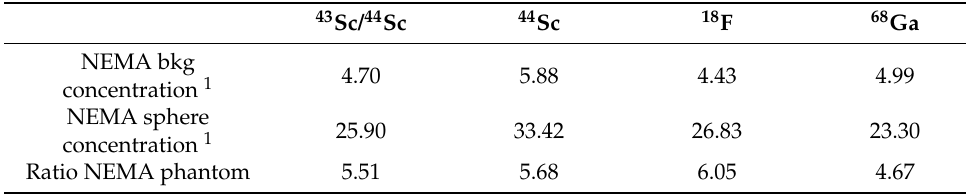
Table 3. Concentration of the radionuclides